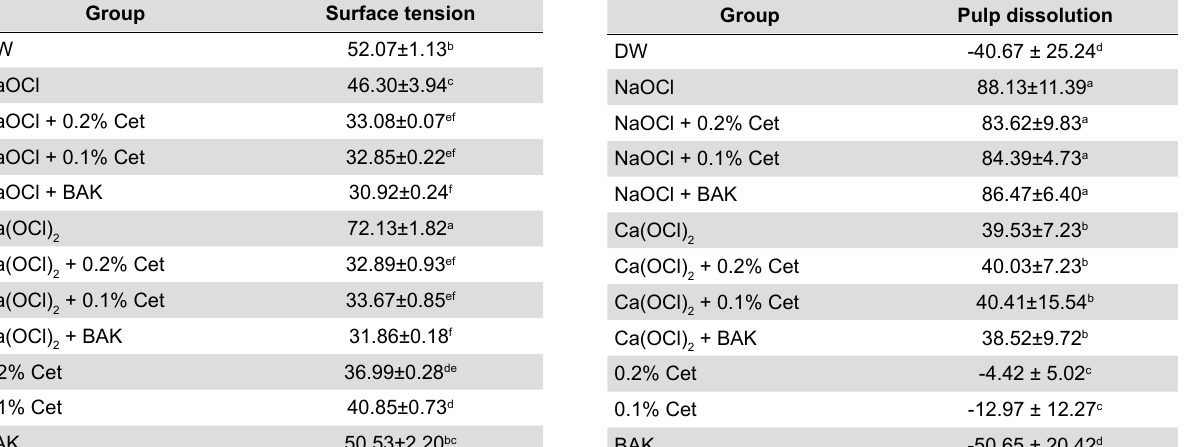
Table 5- Pulp dissolution test (mean percentage reduction in weight of specimens)